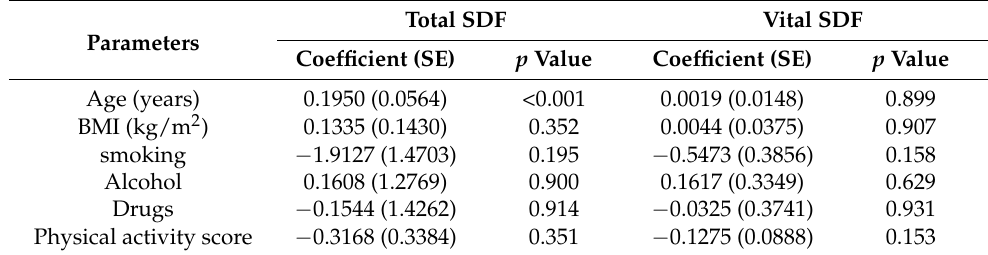
Table 3. Multiple regression analyses between SDF and other lifestyle parameters.